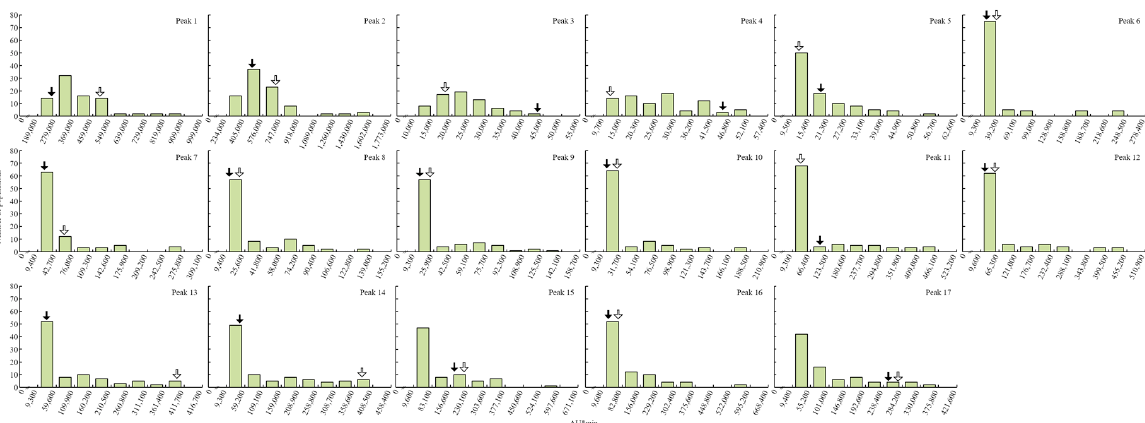
Figure 2. The normal distribution for high-performance liquid chromatography from Peak 1 to Peak 17. The concentrations of metabolites produced after Xanthomonas oryzae pv. oryzae ( Xoo ) inoculation in the 120 CNDH population are all normally distributed. Thus, these metabolites are the result of the interaction of one or more different genes. The black arrow represents Nagdong and the white arrow represents Cheongcheong.